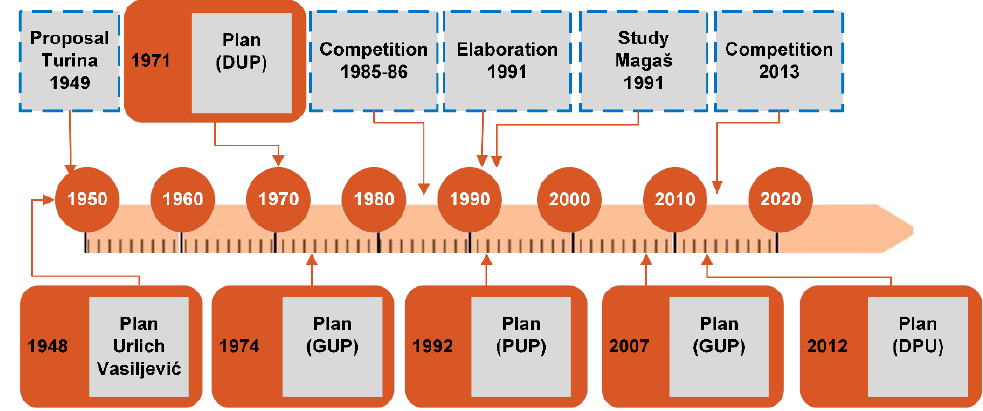
Figure 4. Main planning and design proposals for the area, based on [153–155].